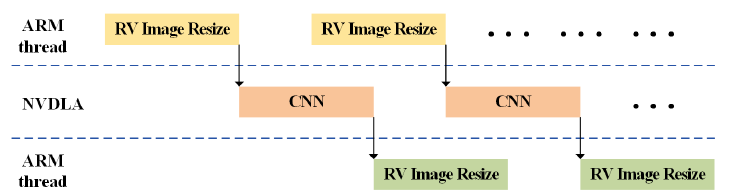
Figure 6. Pipeline processing between the ARM processor and the CNN accelerator.